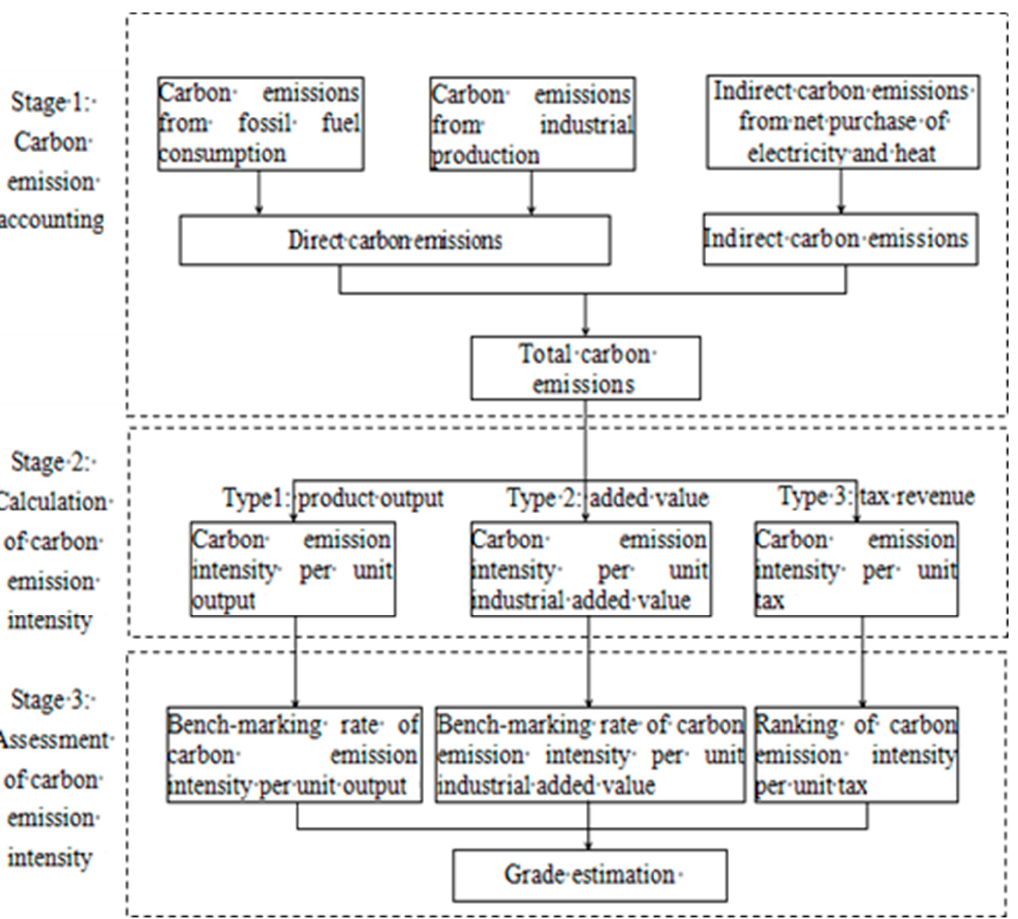
Figure 1. Process of enterprise carbon account evaluation.